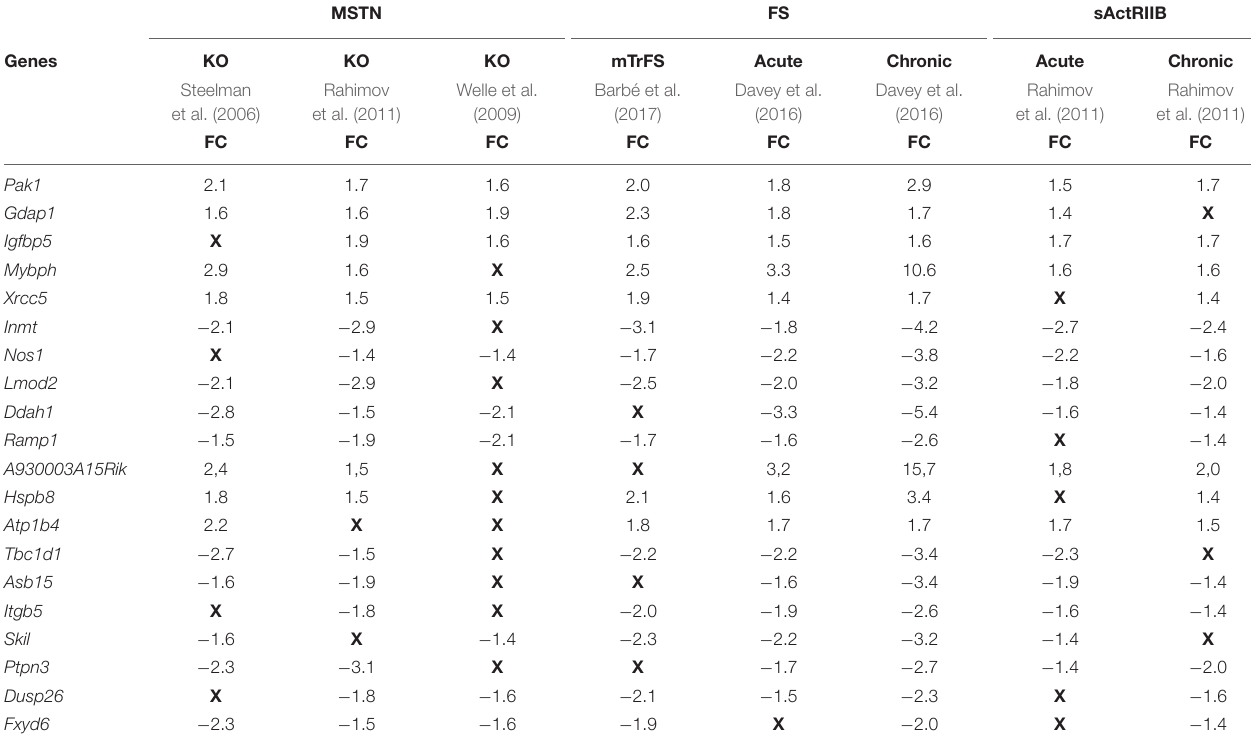
TABLE 2 | Commonly regulated genes following MSTN